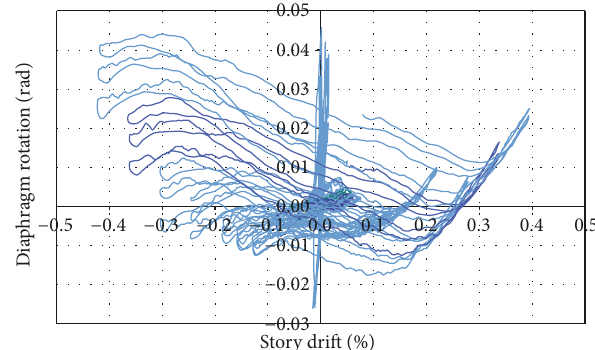
Figure 14: Envelop curves for CBM building.